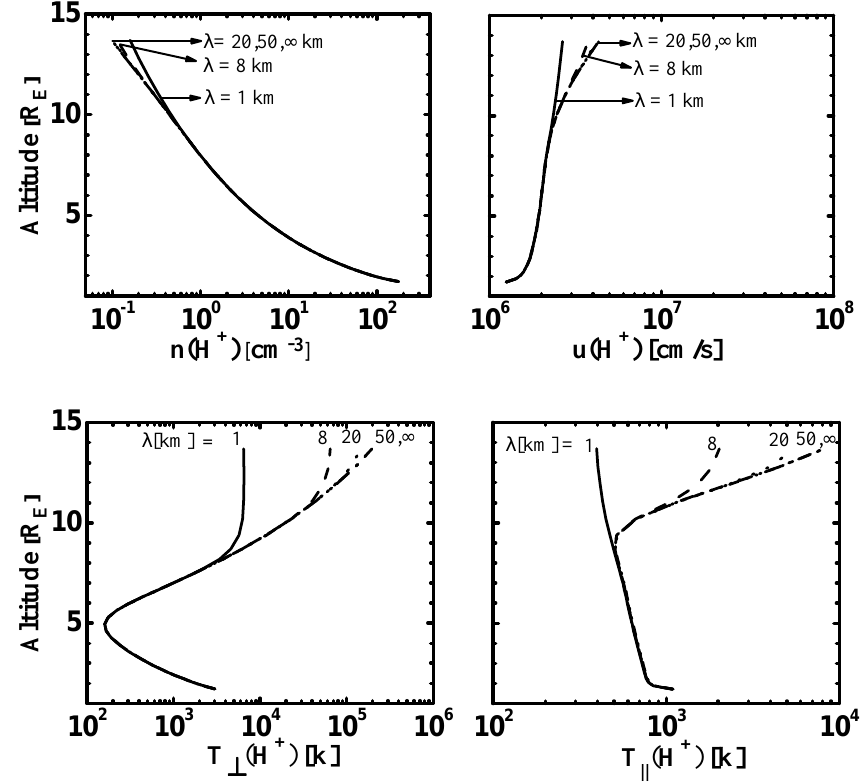
Fig. 5. Altitude profiles of the lower order H + moment for different electromagnetic turbulence wavelengths ( λ ⊥ ) . The wavelengths considered here are λ ⊥ → ∞ (double-dotted dashed line), λ ⊥ = 50km (dotted dashed line), λ ⊥ = 20km (dotted line), λ ⊥ = 8km (dashed line), λ ⊥ = 1km (solid line). The H + moments considered here are: density n( H + ) (top left), drift velocity u( H + ) (top right), perpendicular temperature T ⊥ ( H + ) (bottom left), and parallel temperature T k ( H + ) (bottom right).